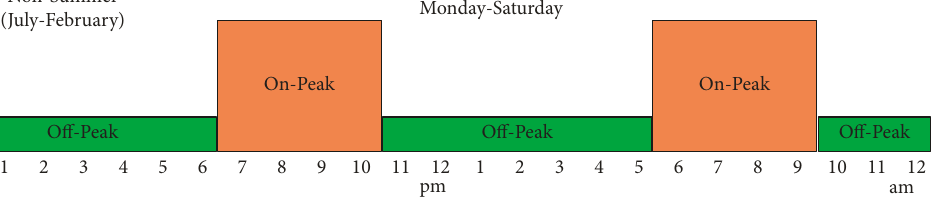
Figure 2: Typical all India load curve [37].